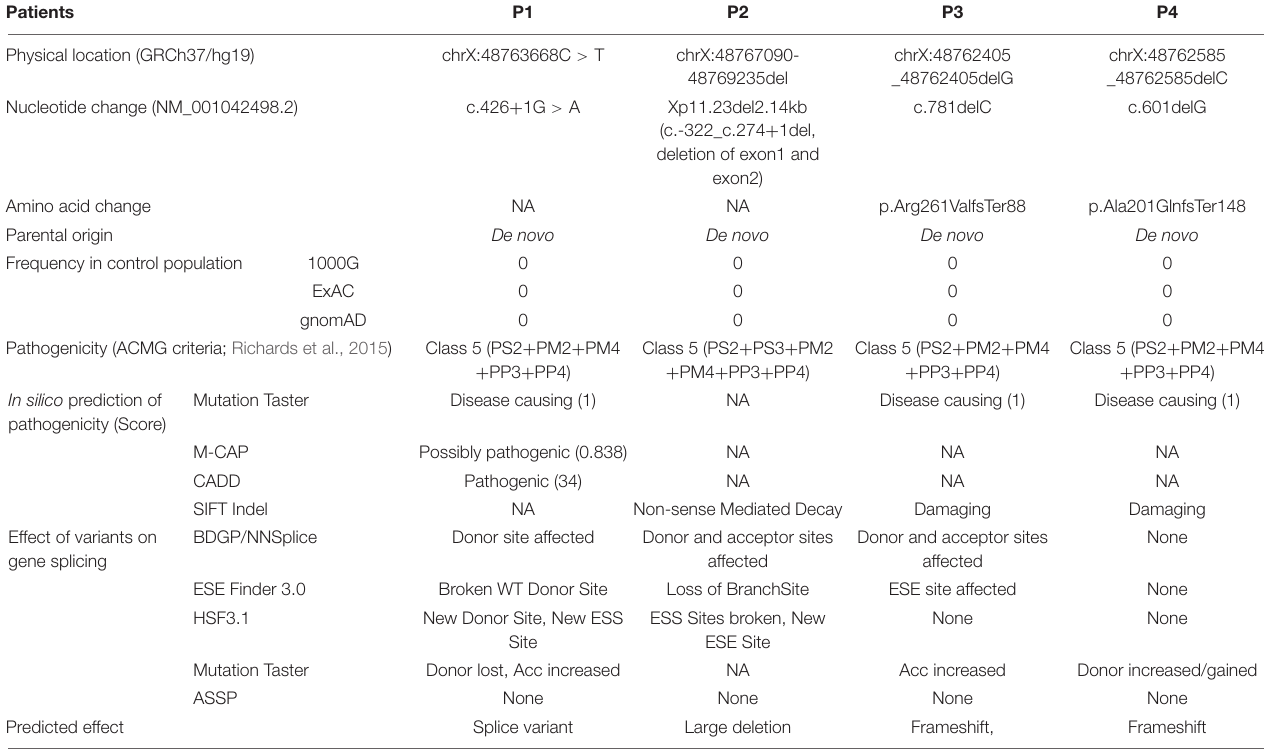
TABLE 2 | SLC35A2 gene mutations, carrier frequency, and in-silico pathogenicity prediction results. Patients